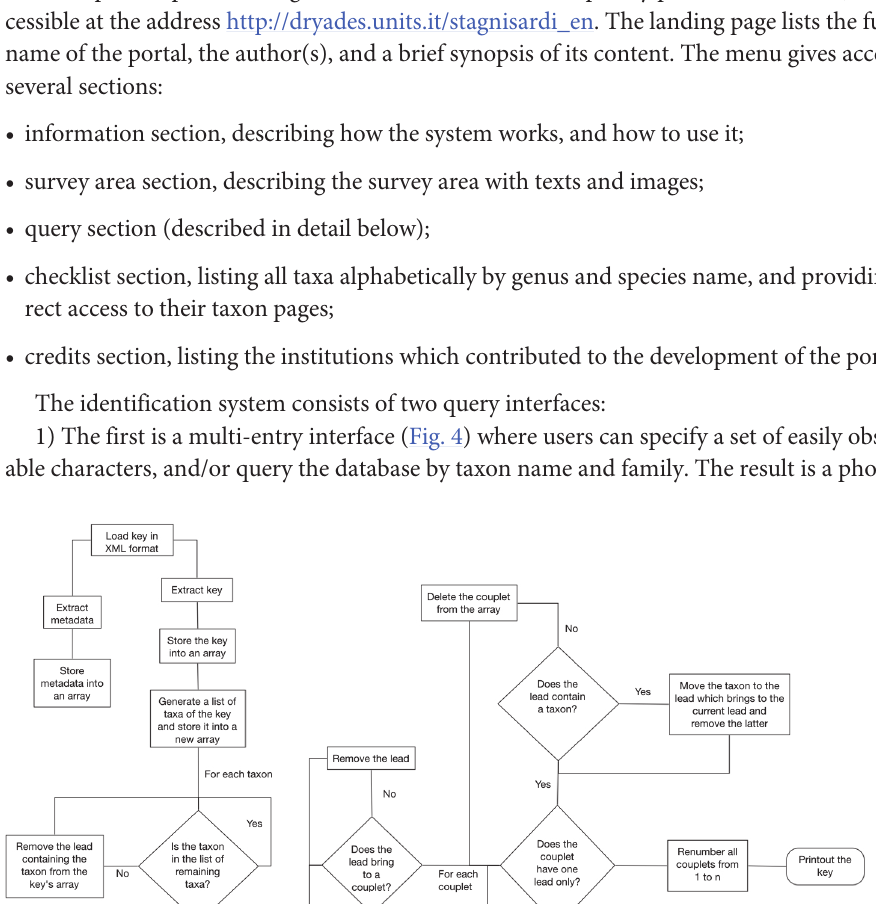
Fig 2. Example of a XML file containing a dichotomous key. The element keyMetadata contains title, authors, introduction, number of taxa and of steps. The element keyData stores the key, and is made of as many lead elements as the leads of the key. Each lead element can contain the following nested elements: leadId, coupletNumber, leadText, leadTo, leadImage, leadSpecies, leadSpeciesId